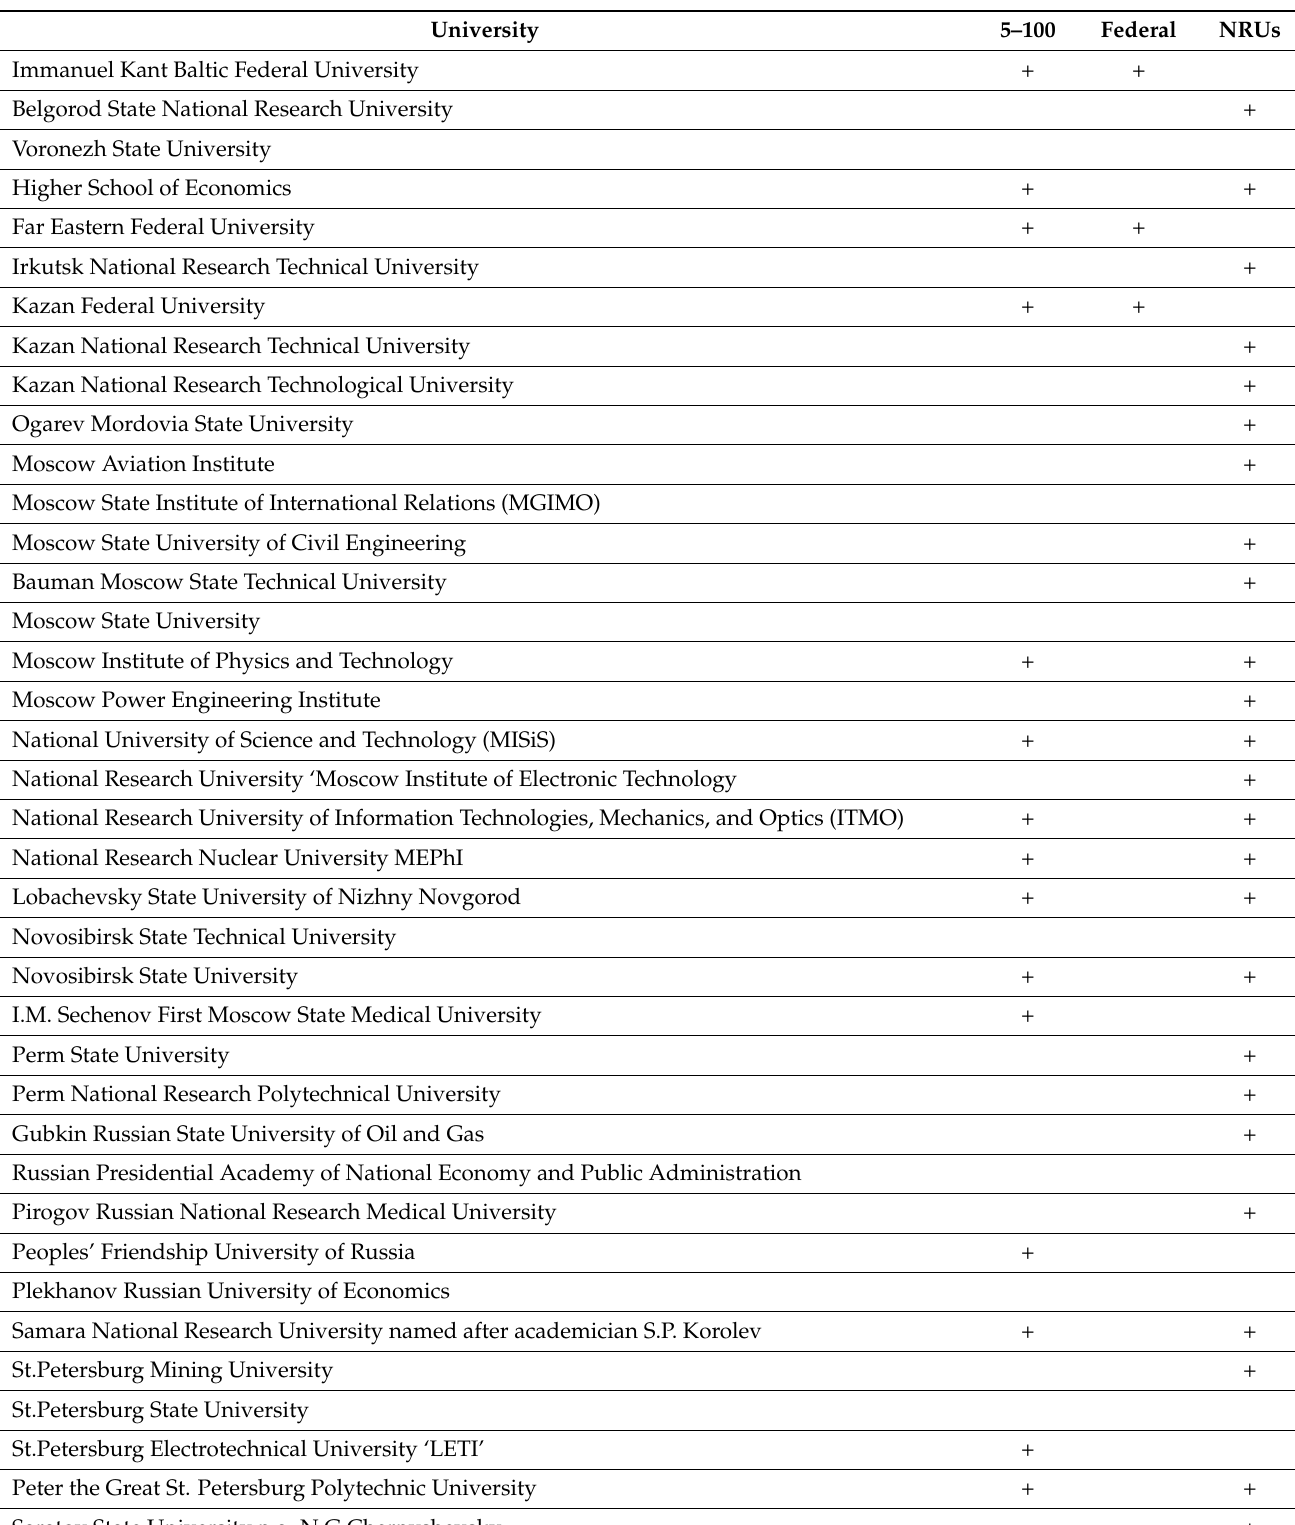
Table 1. Russian universities included in the